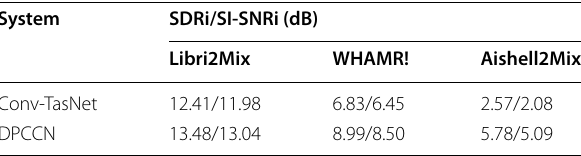
Table 4 SDRi/SI-SNRi performance of DPCCN with CPS-1 and SCT-1 on Aishell2Mix test set